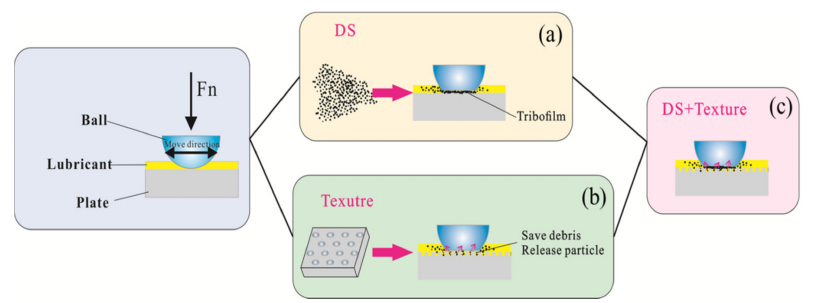
Figure 14. Schematic of the mechanism of the additive on the texture plate: ( a ) The function from DS; ( b ) The effect by texture; ( c ) The combined effect by DS and texture.